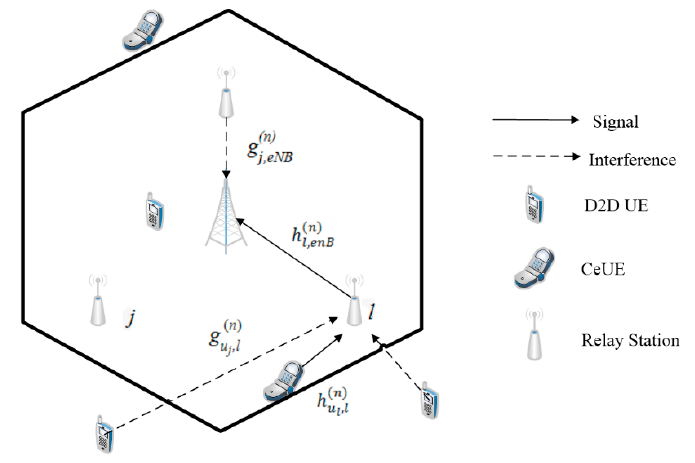
Figure 1. Architecture of systems with deployment of three relay stations.